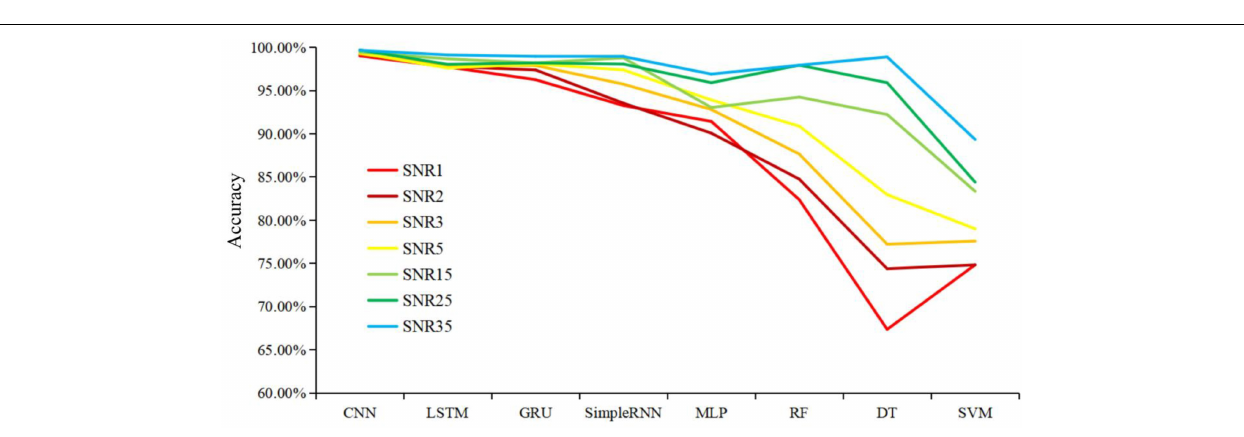
FIGURE 6 | Schematic illustration of the influences of different signal-to-noise ratio on the prediction accuracies of eight machine learning algorithms. X-axis shows different machine learning models. Y-axis represents prediction accuracy of machine learning algorithms under different signal-to-noise ratios. Lines with different colors represent noises intensities. The smaller the signal-to-noise ratio (SNR) value, the more noise added to the spectra and the worse the data quality.